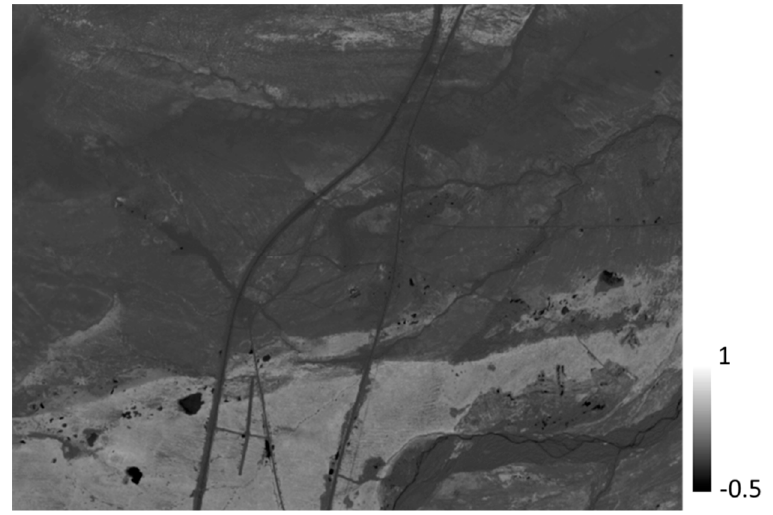
Figure 12. NDVI map of the study area using GF-1 on 18 July 2016.